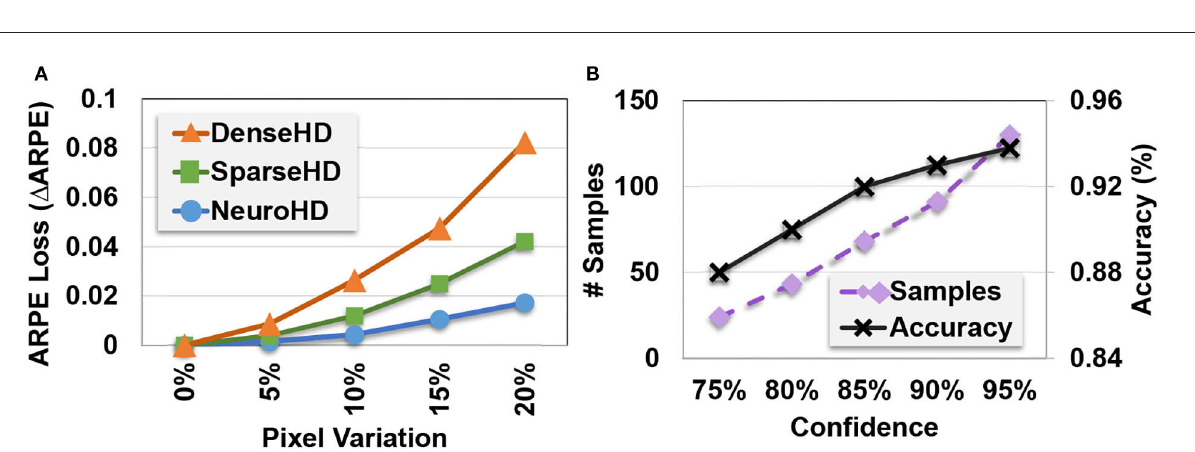
FIGURE7 EventHD robustness and self-learning capability: (A) Robustness to EventHD and other HDC-based algorithms to pixel variation and (B) EventHD self-learning over unlabeled data